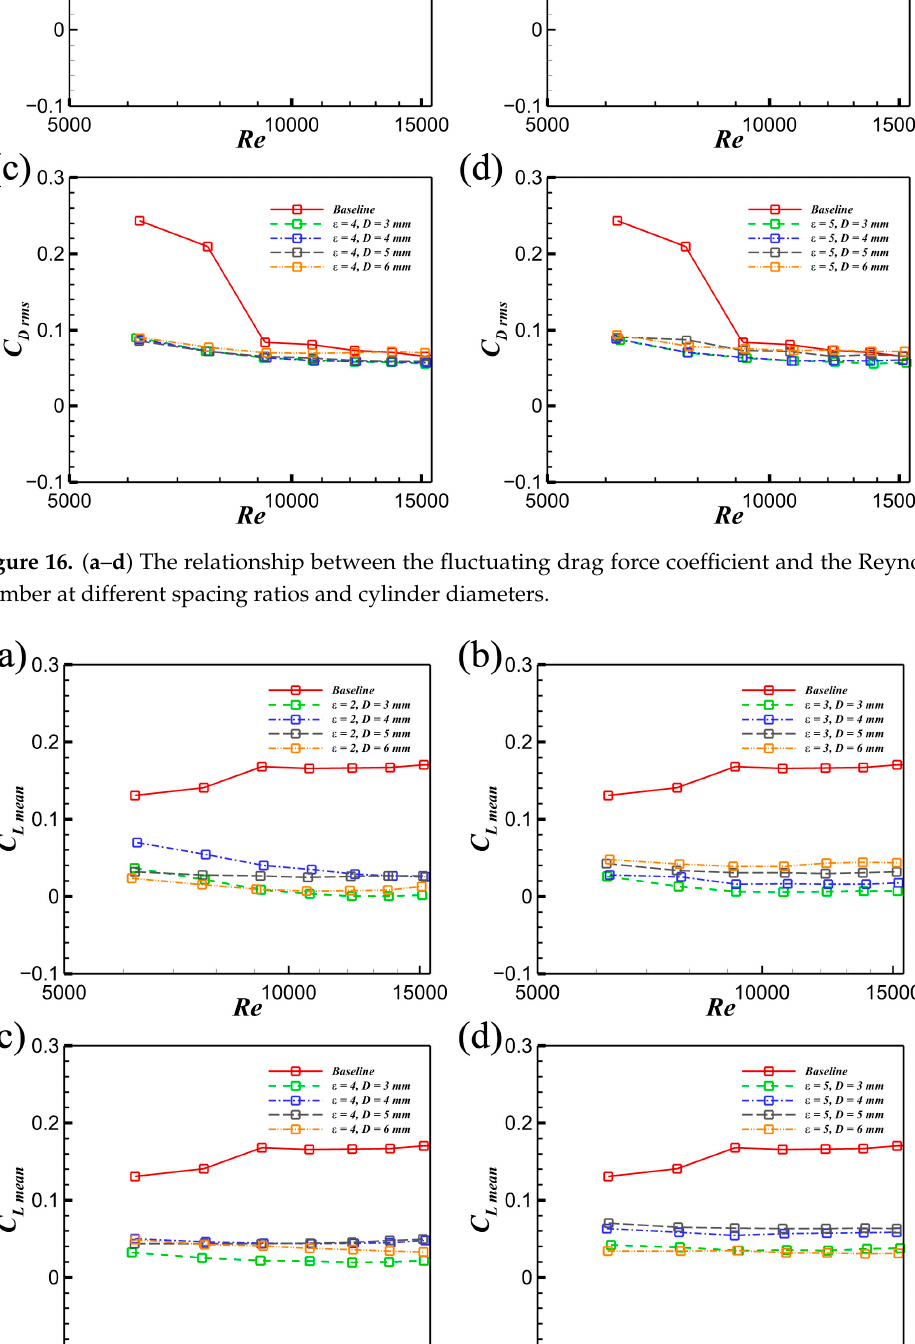
Figure 18. ( a – d ) The relationship between the fluctuating lift force coefficient and the Reynolds number at different spacing ratios and cylinder diameters. Compared with the undisturbed time-averaged moment force, Figure 19 shows that the mean moment force coefficient with cylinder interference is large, and is dependent on spacing ratio and diameter. With the decrease in diameter, the time-averaged moment force coefficient C m mean is slightly enhanced. Meanwhile, with the increase in the spacing ratio, the absolute value of C m mean decreases gradually. When the spacing ratio ε = 5, the